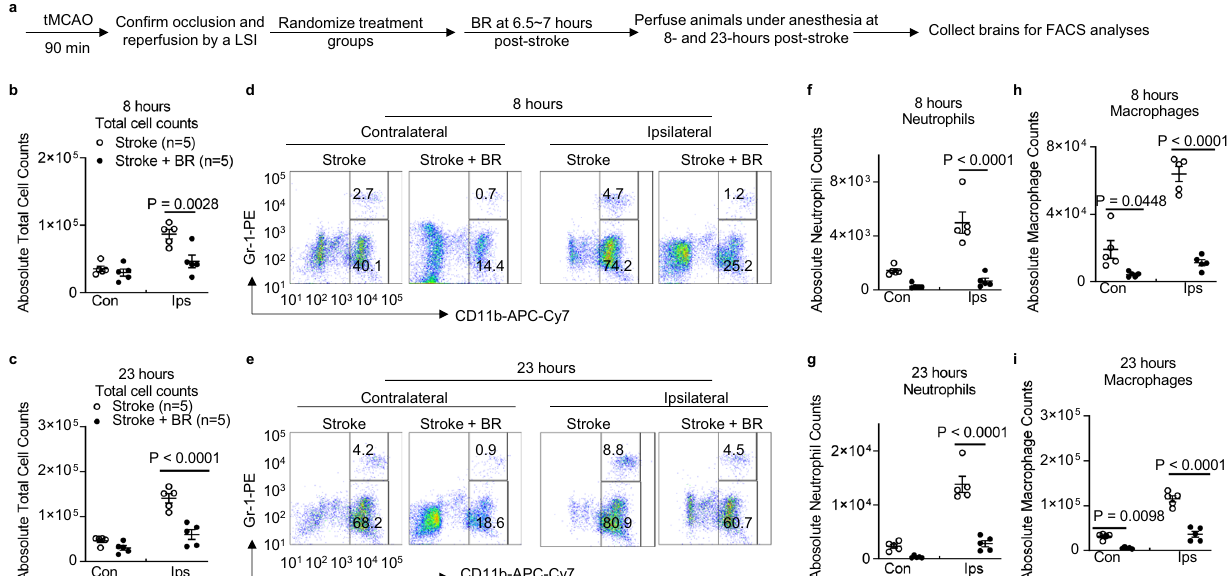
Fig. 6 Blood replacement therapy reduces cell in fi ltration into brains of stroke mice. a Experimental design. Mice (8~12 months old males) underwent tMCAO for 90 min. The occlusion and reperfusion were con fi rmed by a laser speckle imager (LSI). Recipient mice were then randomized into two groups: a control group receiving sham surgery (white circles, n = 5) and a blood replacement (BR) group receiving 500 µ l of blood from healthy donors (black circles, n = 5). Blood was replaced into stroke mice at 6.5~7 h post stroke. The same volume of blood was withdrawn from the recipient stroke mice during blood transfusion. Brains were perfused and analyzed at 8 and 23 h after ischemia induction. Blood from naive donors reduced numbers of total in fl ammatory cells in ischemic hemispheres at b 8 and c 23 h post stroke. Representative fl ow cytometry images for neutrophils gated on propidium iodide (PI) − CD45 + CD11b + Gr-1 + populations and macrophages gated on PI − CD45 + CD11b + Gr-1 − populations in hemispheres at d 8 and e 23 h post stroke. Blood from naive donors reduced numbers of absolute neutrophil counts in ischemic hemispheres at f 8 and g 23 h post stroke. Blood from naive donors reduced numbers of absolute macrophage counts in ischemic hemispheres at h 8 and i 23 h post stroke. Data were presented as means ± SEM. One-way ANOVA